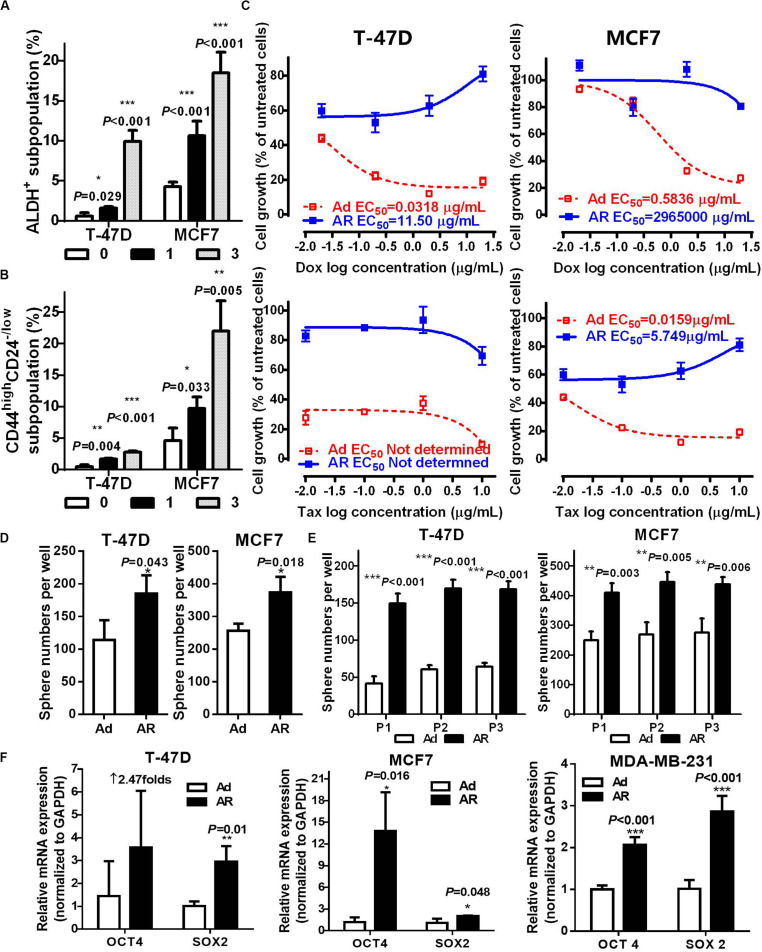
Detachment increases functional ALDH+ or CD44highCD24– /low CSCs. ALDH+
(A) and CD44highCD24– /low
(B) subpopulation analysis in T-47D and MCF7 cells cultured under an attached or detached condition for 0, 1, or 3 days. (C–F) Cells were cultured under an Ad or AR condition for 7 days, and then used for the following experiments: (C) Cytotoxicity of Doxorubicin (Dox) and Taxol (Tax) in T-47D and MCF7 cells. (D,E) Tumorsphere numbers without or with passaging in T-47D and MCF7 cells. (F) qRT-PCR analysis of OCT4 and SOX2 mRNA levels in T-47D, MCF7, and MDA-MB-231 cells.